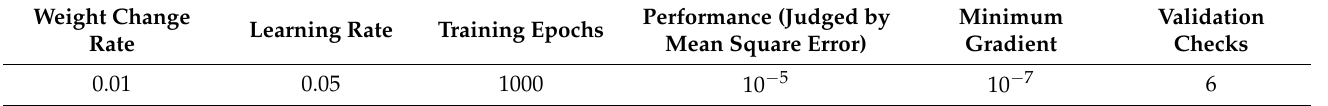
Table 2. Training